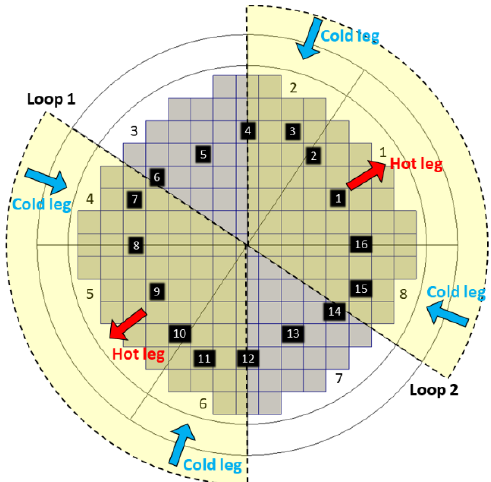
Figure 21. The AP1000 selected cells (assemblies in CA-V) whose coolant temperature evolutions are studied.